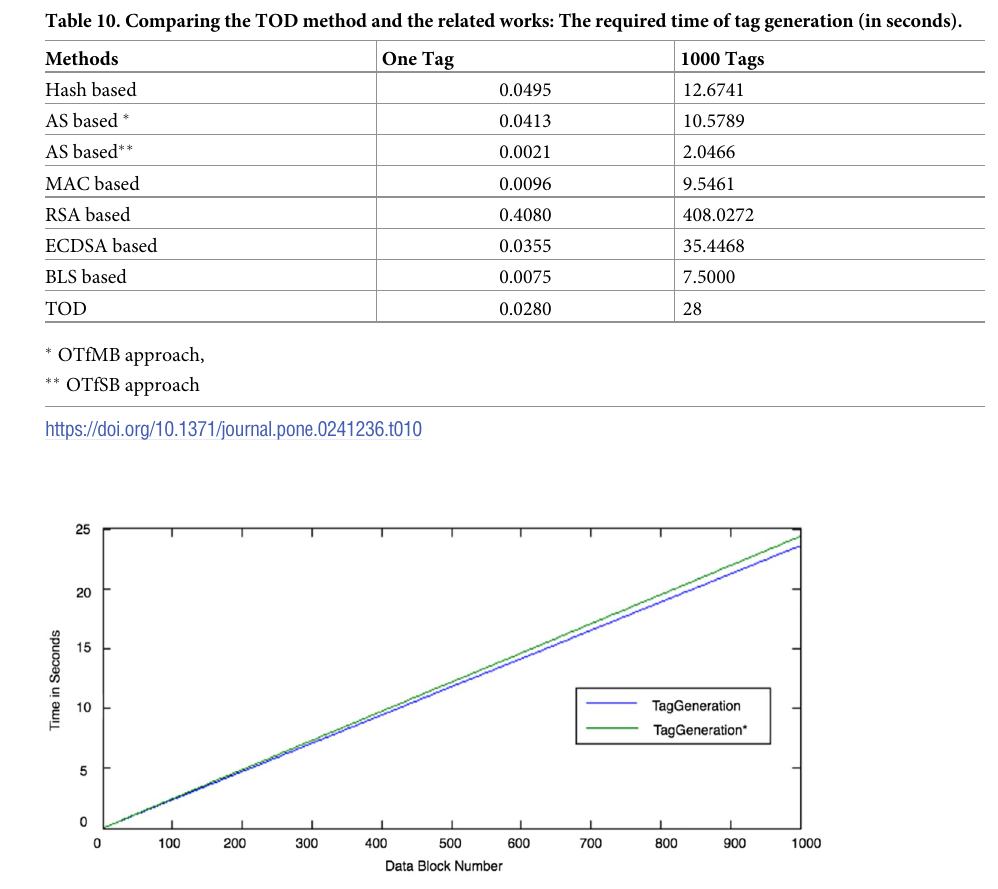
Fig 14. Tag generation cost vs data blocks